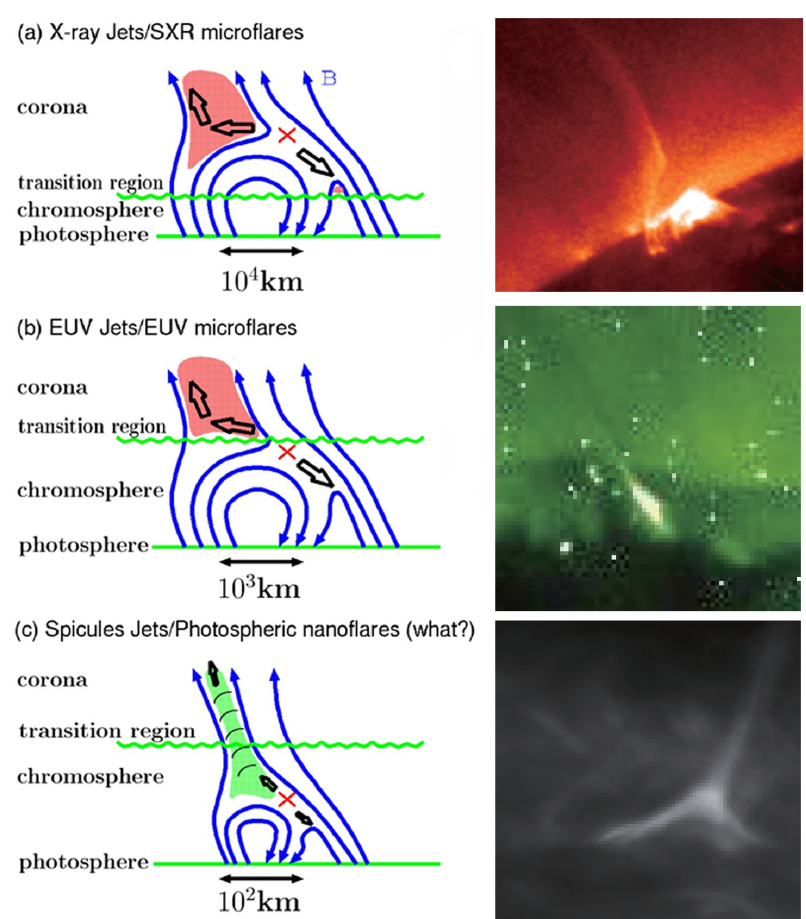
Figure 53: Left: Schematic illustration of jets associated with emerging flux observed in different scales. Image reproduced with permission from Shibata et al. (2007), copyright by AAAS. Right: example of observed jets in different scales. From top to bottom, an X-ray jet observed by the X-ray Telescope of Hinode, an EUV jets observed in Fe xii 195 ˚A filter by TRACE (Nishizuka et al. , 2008), and a chromospheric jet observed by the Solar Optical Telescope of Hinode (Singh et al. ,